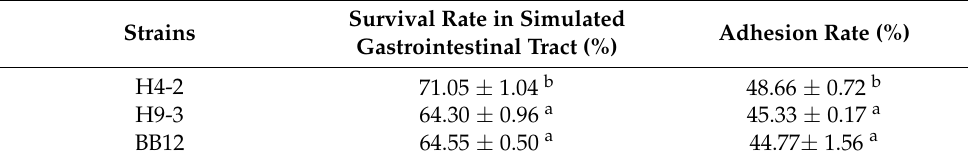
Table 4. Gastrointestinal tolerance and adhesion characteristics of